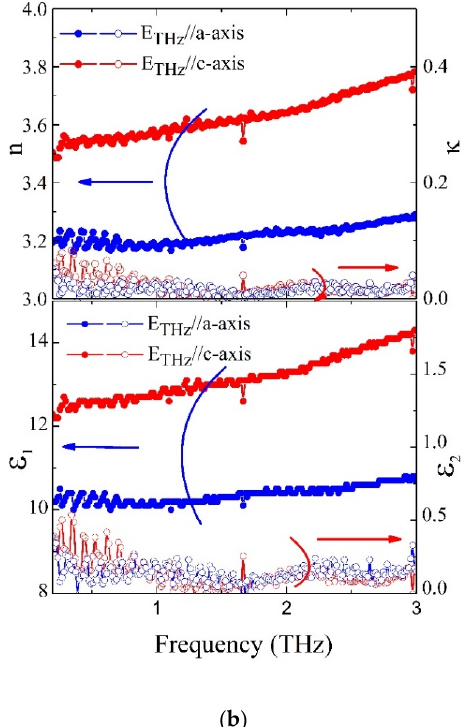
Figure 2. ( a ) Waveforms of the THz pulses transmitted through the excited Fe-doped (010) β -Ga 2 O 3 along E THz //a-axis and E THz //c-axis at 808 nm. ( b ) calculated refractive index and complex dielectric constants.